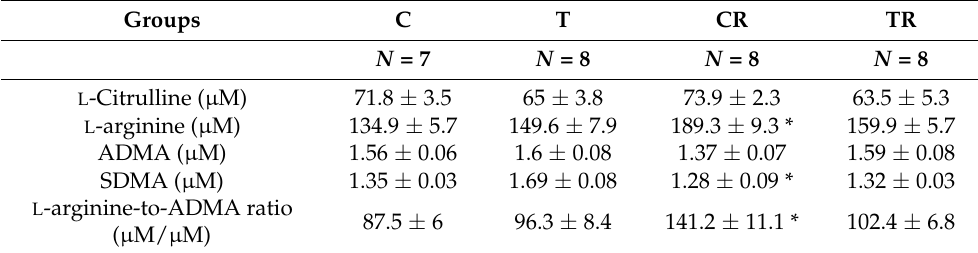
Table 4. Plasma NO-related parameters.